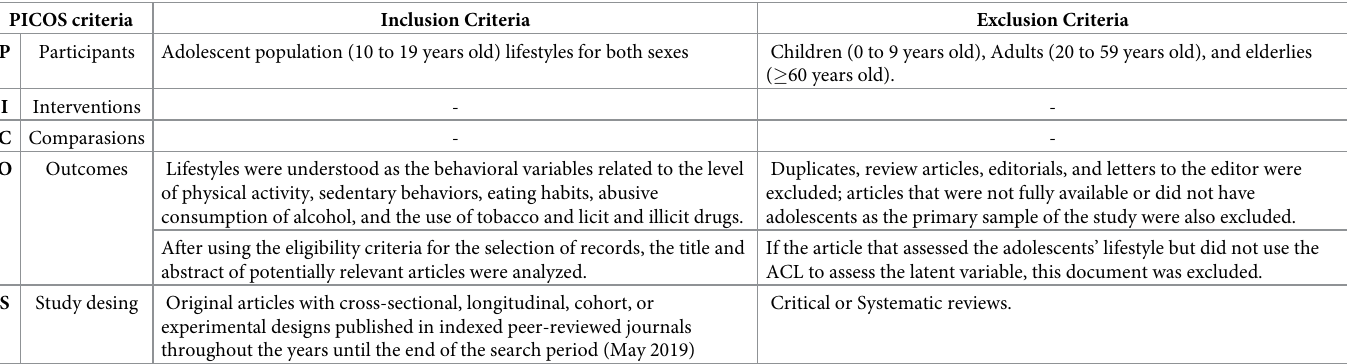
Table 1. Participants, interventions, comparisons, outcomes, and study design (PICOS) used as eligibility characteristics in this systematic review. PICOS criteria Inclusion Criteria Exclusion